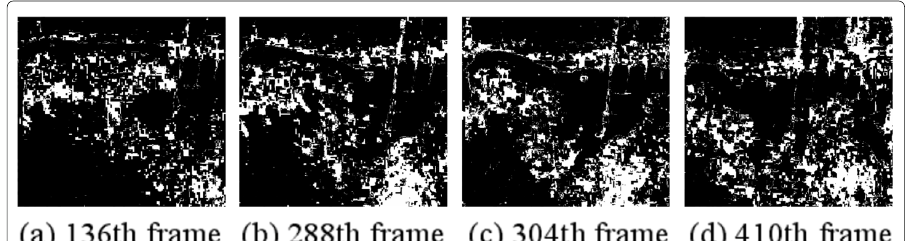
Fig. 7 The associated probability projection of the method in this paper